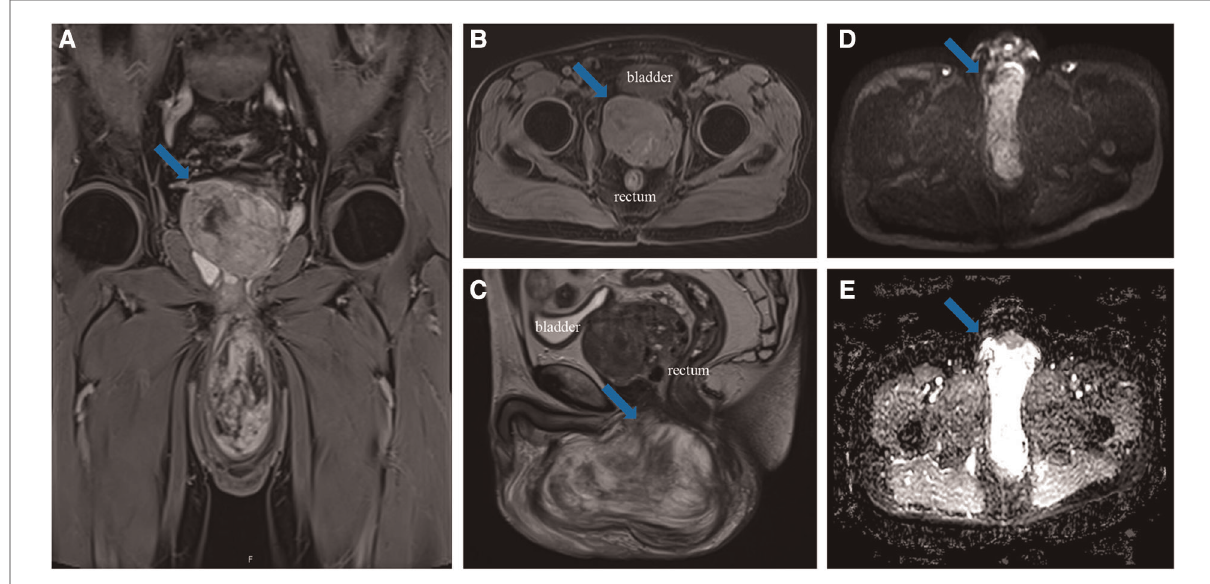
FIGURE 1 ( A ) coronal (weighted-sequence T1), ( B ) axial (weighted-sequence T1), ( C ) sagittal (weighted-sequence T2), ( D ) axial (DWI), and ( E ) axial (ADC) MRI reveal a well-capsulated mass protruding into the left scrotum in the left pelvis (arrows). ADC mean value=2.16×10 − 3 mm 2 /s. MRI, magnetic resonance imaging; DWI, diffusion-weighted imaging; ADC, apparent diffusion coef fi